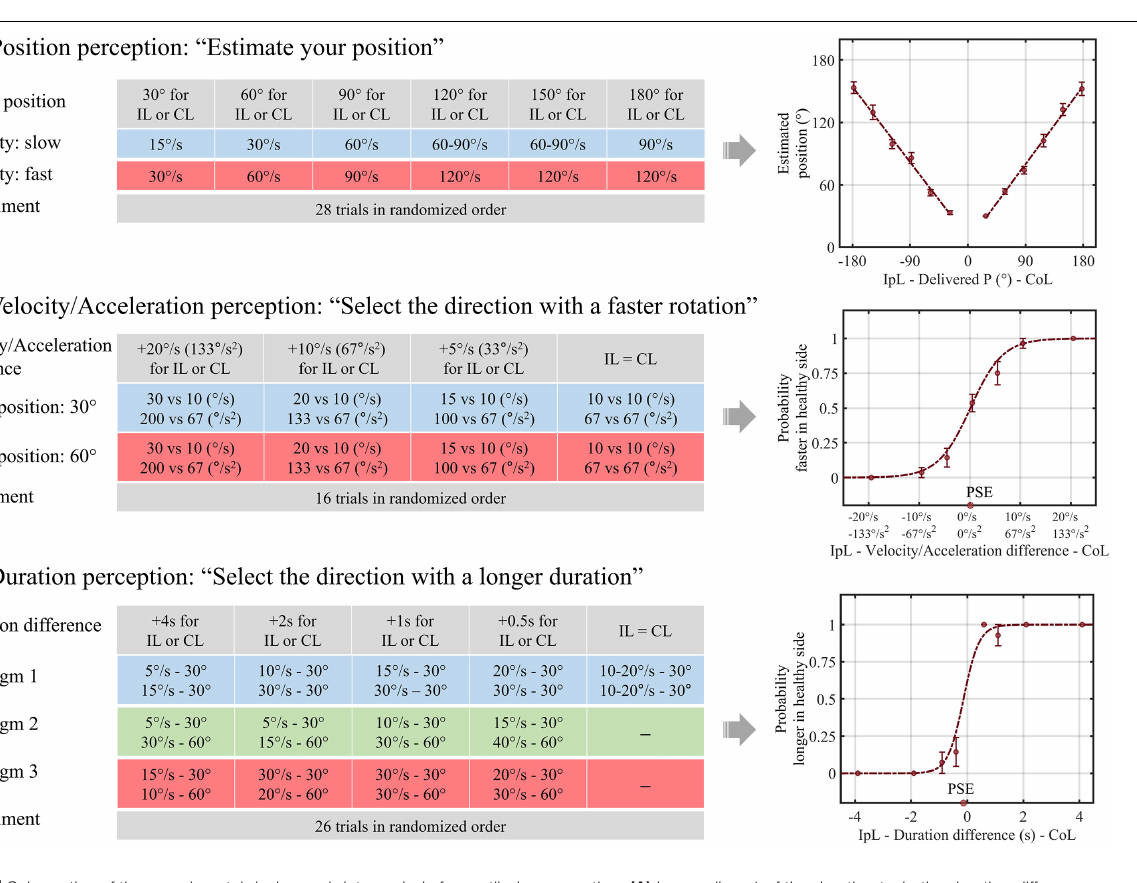
FIGURE 1 | Schematics of the experimental design and data analysis for vestibular perception. (A) In paradigm 1 of the duration task, the duration difference was created by delivering equal amplitude rotations with different velocities. In paradigms 2 (B) and 3 (C) , longer and shorter rotation durations were assigned for larger rotational amplitudes, respectively. IpL, ipsilesional; CoL, contralesional; P, position; PSE, point of subjective